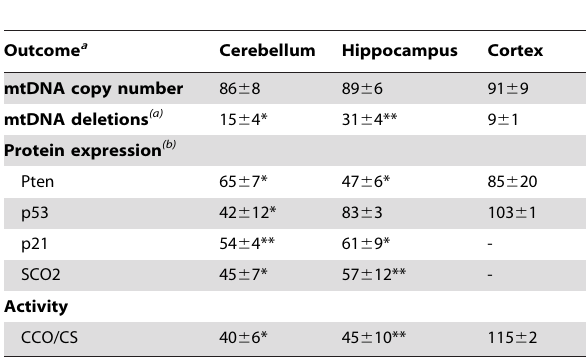
Table 3. p53 and p53-downstream targets, CCO activity, mtDNA copy number and deletions in Pten haplo-insufficient mice aged 20–29 weeks.